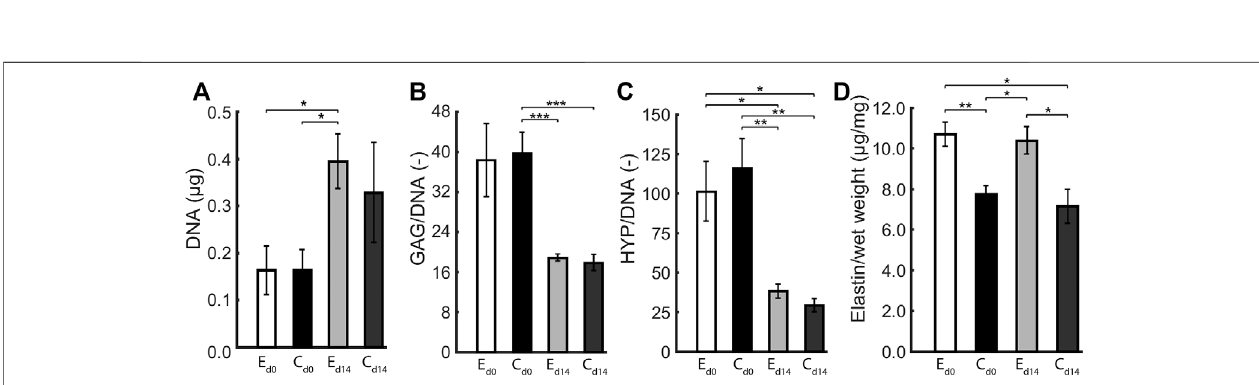
FIGURE 4 | Evolution of the principal elastic stretch (A) , tangent stiffness of the principal stress-stretch curve (B) , principal Cauchy stress (C) , and strain energy density (D) at6 kPainthecentral50%ofellipticalandcircularconstructsduringdynamicloading.In (A – C) themaximumandmiddleprincipalcomponentfortheelliptical constructs and the maximum component for the circular constructs are given. In the ellipses, the maximum and middle principal components of the Cauchy stress and stretch are directed along the short and long axis approximately. See supplemental material for p -values.